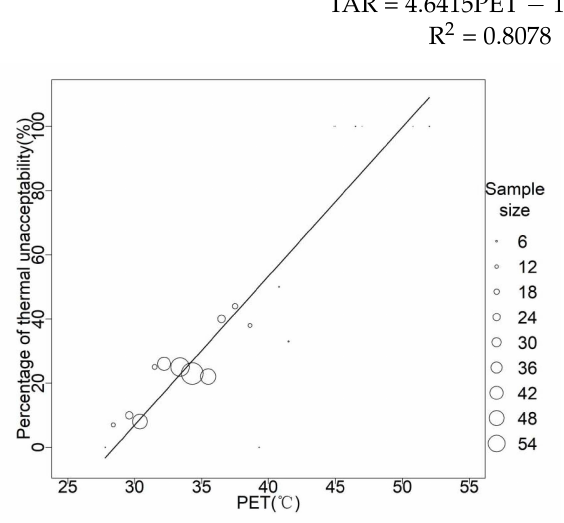
Figure 8. Relationship between the thermal unacceptable range and PET.